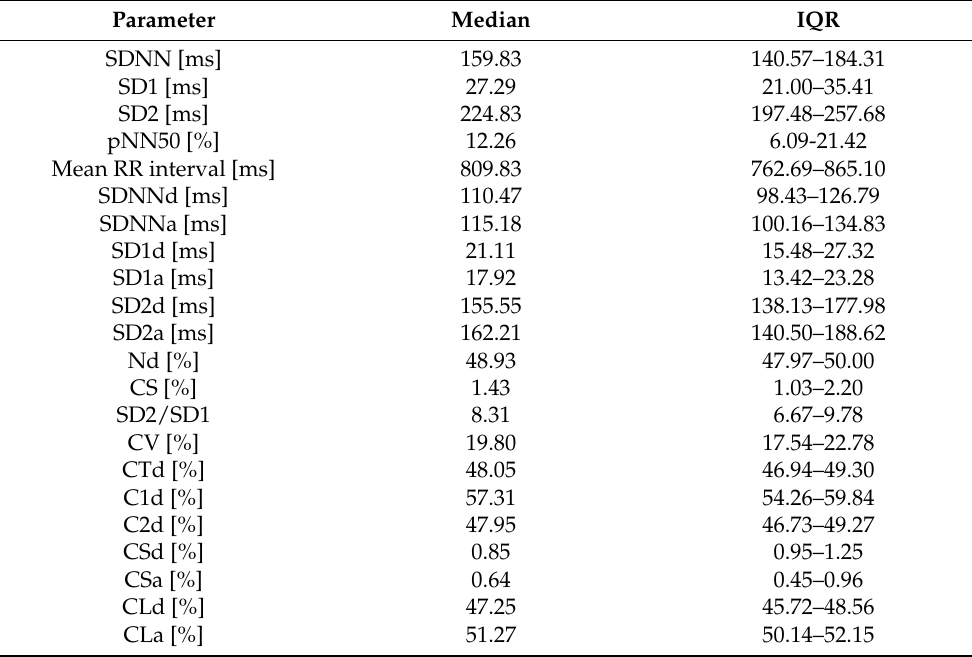
Table 1. HRV and HRA parameters for all studied subjects (n = 101) from 48-h ECG recordings of carefully selected healthy